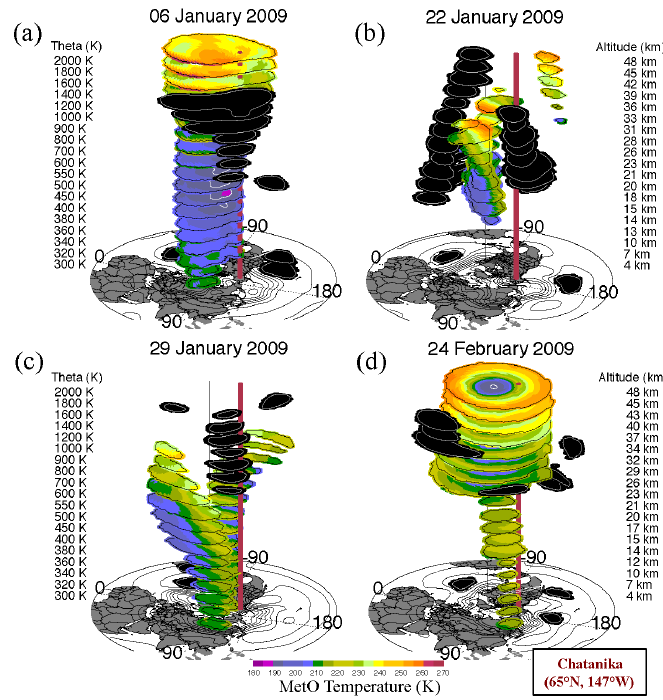
Figure 6. 3D structure of the stratospheric vortex and anticyclones plotted for four days in January–February 2009. The altitude is given in terms of potential temperature, theta, on the left and corresponding altitude on the right. ( a ) The vortex and anticyclone(s) before an SSW; ( b ) the vortex and anticyclone(s) at the beginning of the SSW; ( c ) the vortex and anticyclone(s) a week later; ( d ) the vortex and anticyclone(s) after the reformation of the vortex. The red vertical line marks the location of Poker Flat Research Range (PFRR), Chatanika, Alaska.